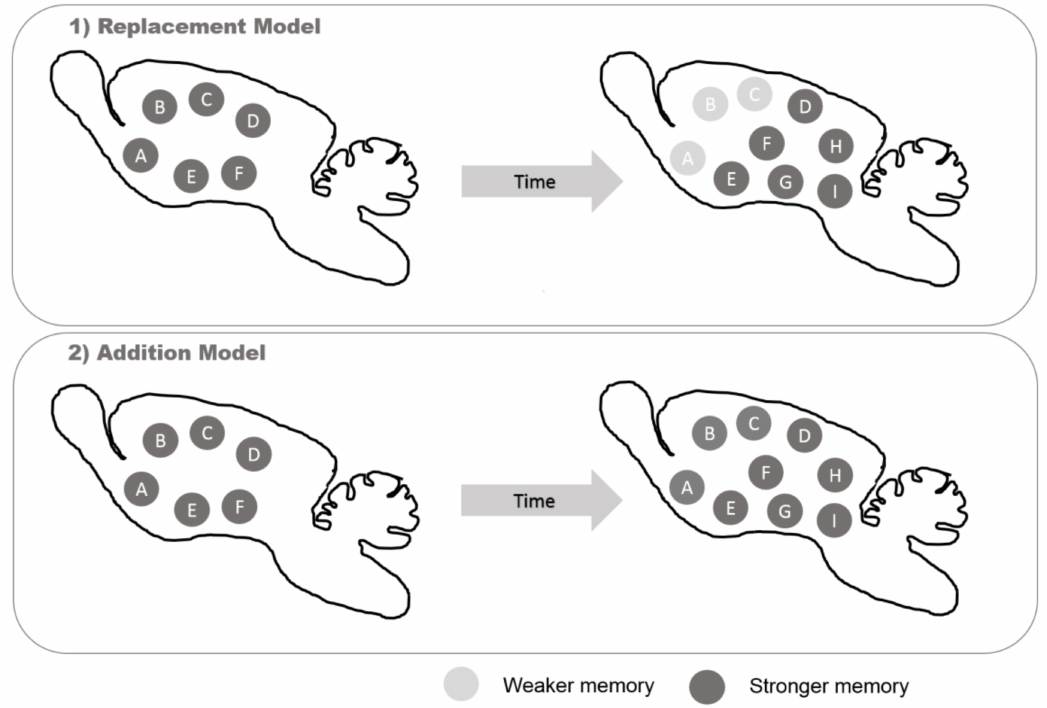
Figure 2. Examples of neurogenic models. The “replacement model” would replace dead neurons and prioritize new memories because older memories would be lost as older neurons lose their synaptic connection and are replaced by new ones. The “addition model” would prioritize more hard networks as newborn neurons are constantly added to the circuit and retain older memories. Although both models exist simultaneously, the two models and their possible consequences are investigated as some predominance of one or the